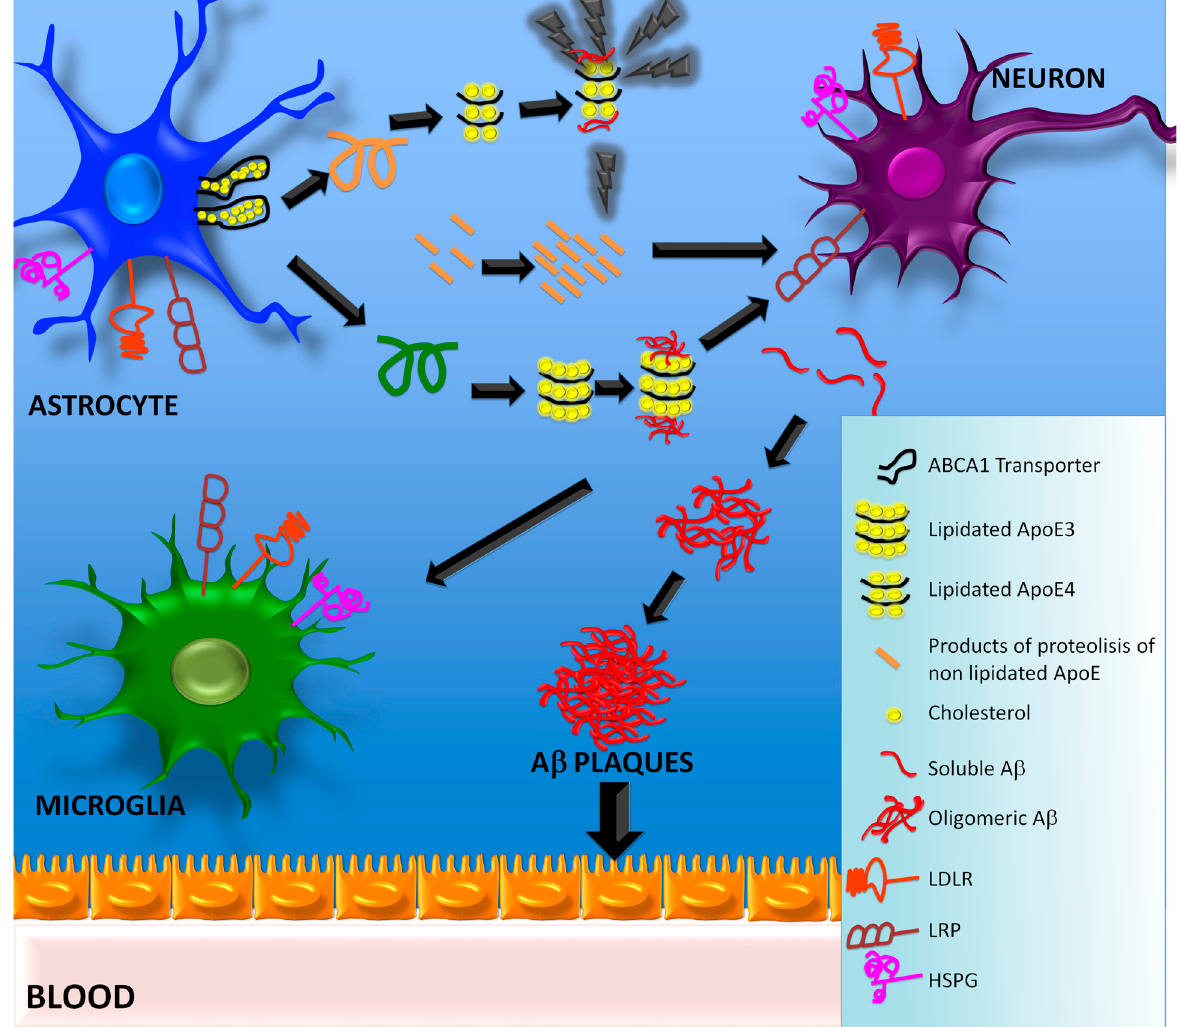
Figure 2. ApoE lipidation process. Astrocytic ApoE is the main source of ApoE in the brain. To accomplish its functions, after being synthesized, ApoE must be lipidated with cholesterol, triglycerides, and phospholipids. The ApoE lipidation process begins when ABCA1 translocates lipids to the plasma membrane, binds to the free form of apolipoproteins, and promotes their acceptance of the lipids translocated. The internalization of ApoE-lipid complexes by neurons is mediated by receptors like HSPG, LDLR, and LDLRP. The degree of lipidation, size, and content of ApoE-lipid complexes are isoform dependent; ApoE4 is poorly lipidated when compared to the other isoforms. When ApoE is not lipidated, it can form toxic aggregates in the neurons that can evade the secretory pathway, stimulate tau phosphorylation, and cause mitochondrial dysfunction. Lipidated ApoE has higher A β binding affinity than delipidated molecules, which enhances the clearance of A β through the blood stream and prevents its